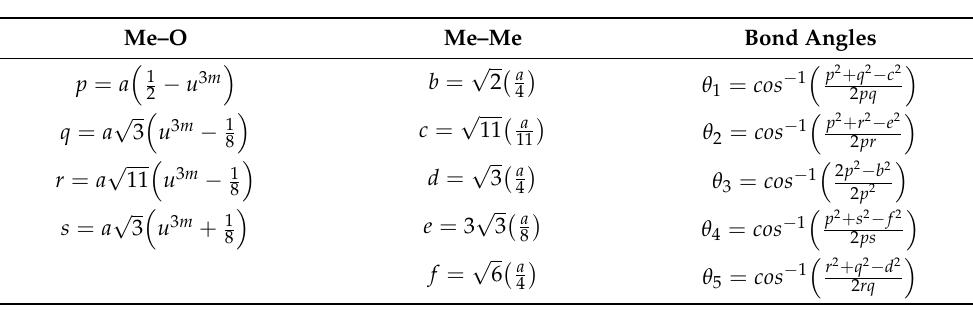
Figure 11. A-B, B-B and A-A interactions of CoCr 0.5 Dy x Fe 1.5-x O 4 . Table 7. Equations to obtain the cation-anion ( Me–O ) and cation-cation ( Me–Me ) lengths and bond angles. Here ‘a’ is the lattice constant and ‘u’ is the oxygen positional